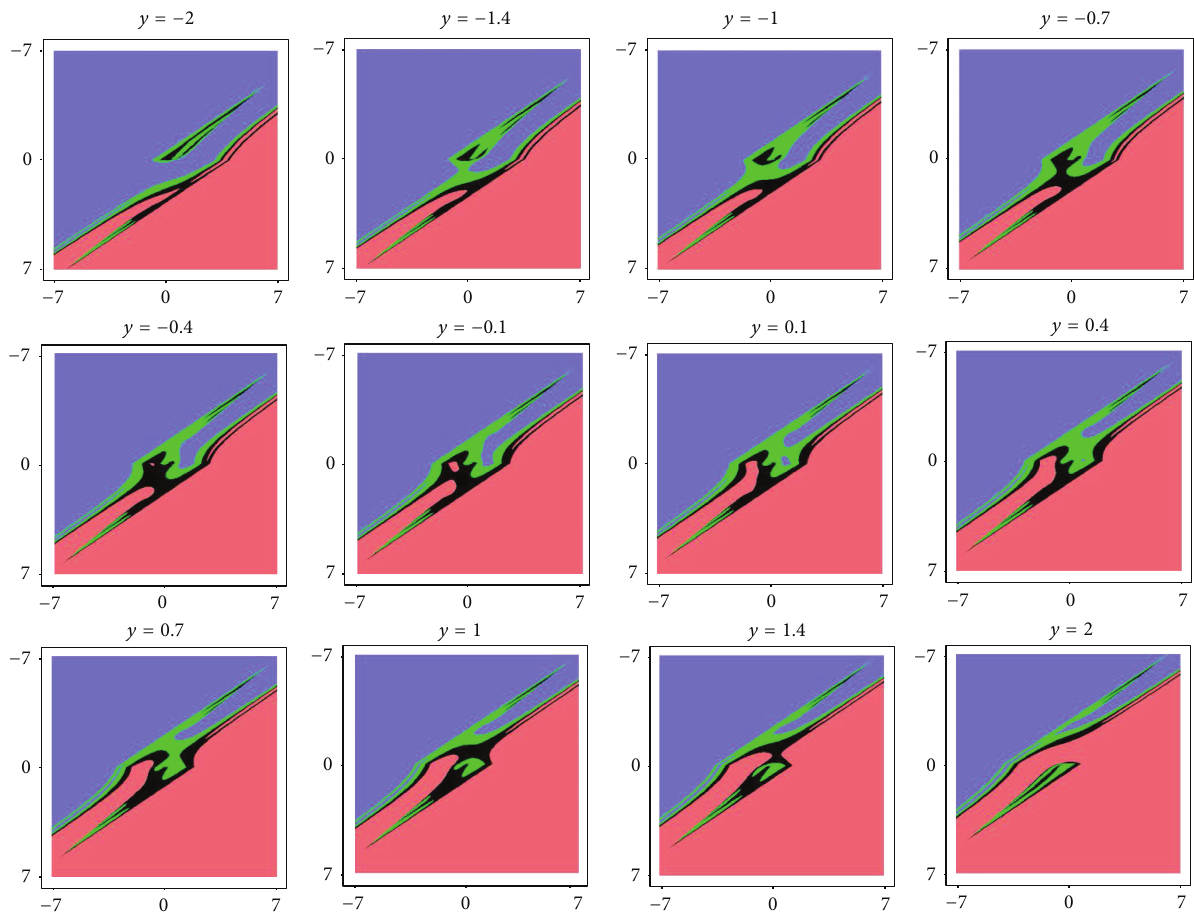
Figure 8: The graphical illustration of the basin of attraction for chaotic attractor, system case 𝐵 . These slices are cross-sections of the 𝑦 -axis where 𝑦 = {−2,−1.4, −1,−0.7, −0.4, −0.1, 0.1, 0.4, 0.7, 1, 1.4, 2} (left to right). Black and green regions mark basins of attraction for case 𝐴 and case 𝐵 , respectively. Blue and red regions denote unbounded